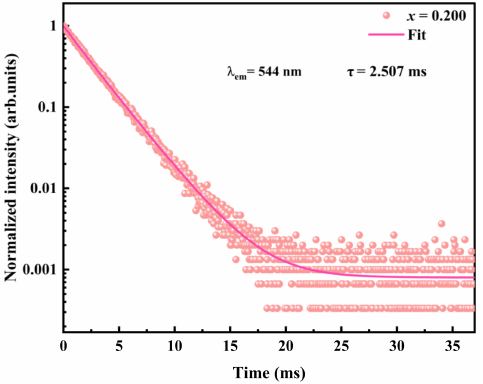
Figure 15. Fluorescence-decay curve for the Tb 3+5 D 4 → 7 F 5 transition in the (ZrO 2 ) 92 (Y 2 O 3 ) 7.800 (Tb 4 O 7 ) 0.200 single-crystals before annealing.